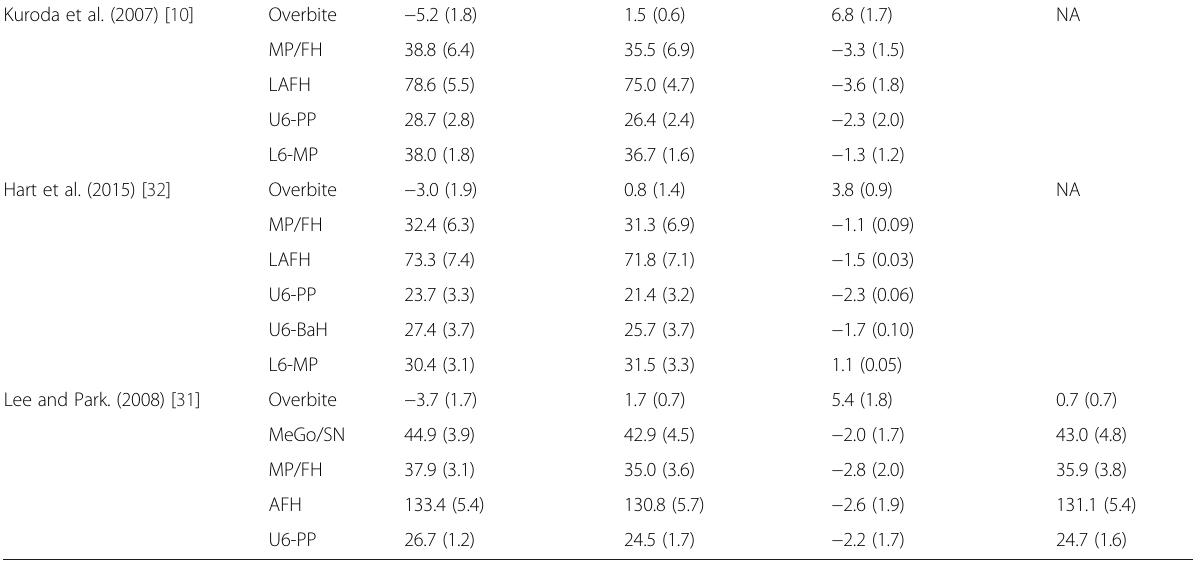
Table 4 Summary of outcome measurements of the selected studies (Continued) Kuroda et al. (2007) [10]